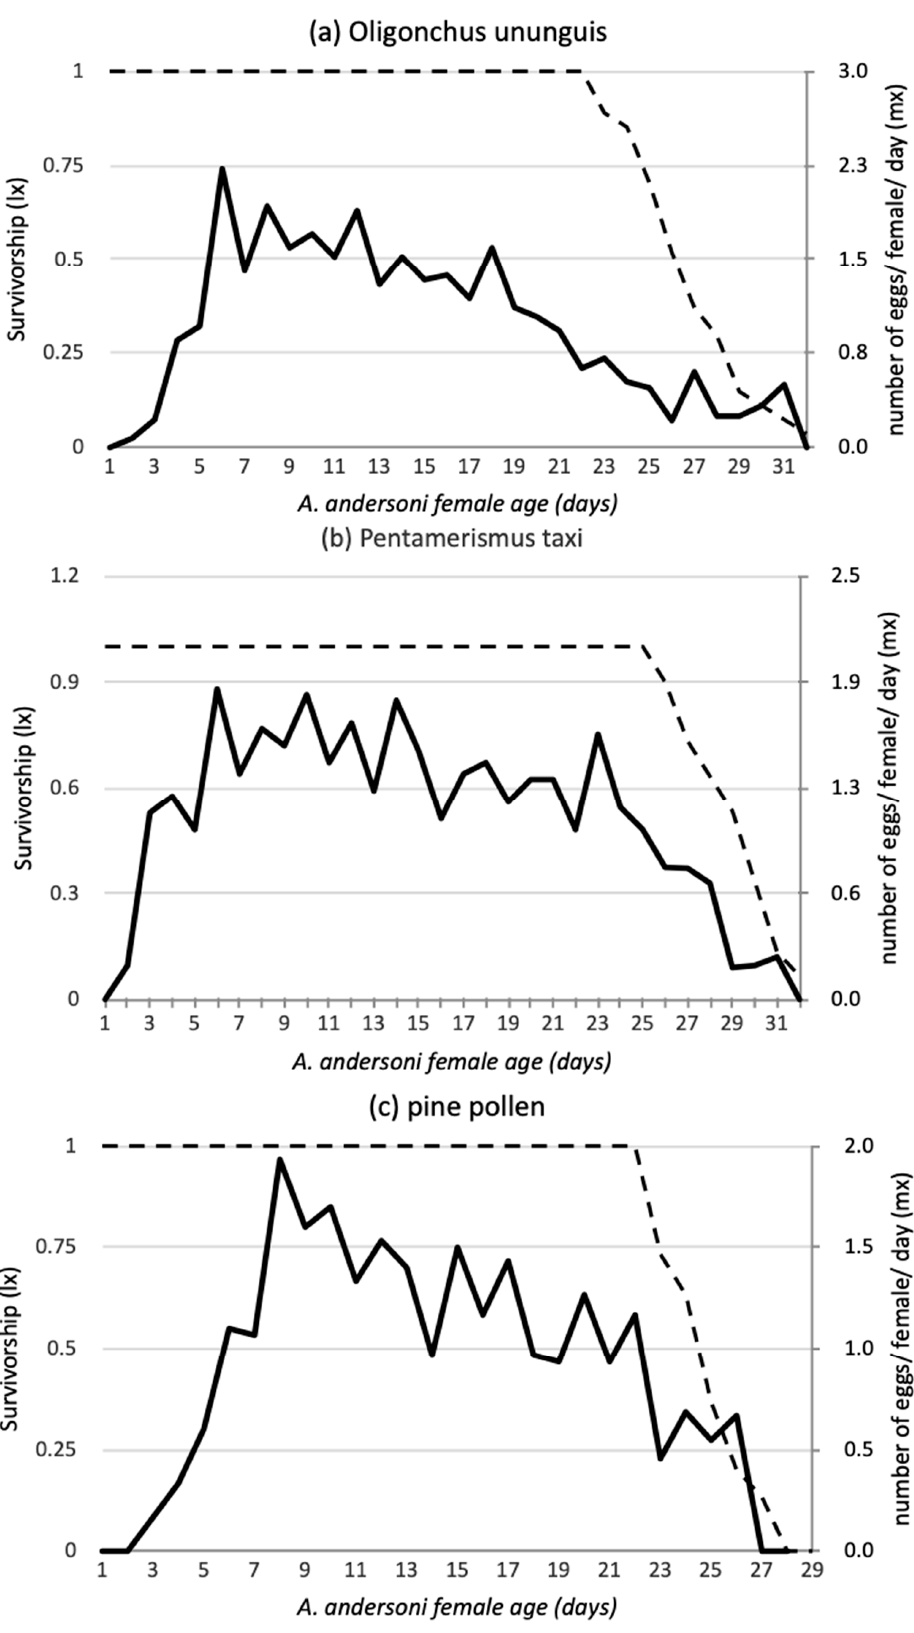
Figure 1. Age-specific survival rate (m x -dashed line) and fecundity (l x -solid line) of Amblyseius andersoni females reared on ( a ) Oligonychus ununguis, ( b ) Pentamerismus taxi and ( c ) Pinus sylvestris pollen. Table 3. Mean (±SE) life table parameters of Amblyseius andersoni reared on Oligonychus ununguis , Pentamerismus taxi or pine pollen. Values with different letters in a row differ significantly at p ≤ 0.05.